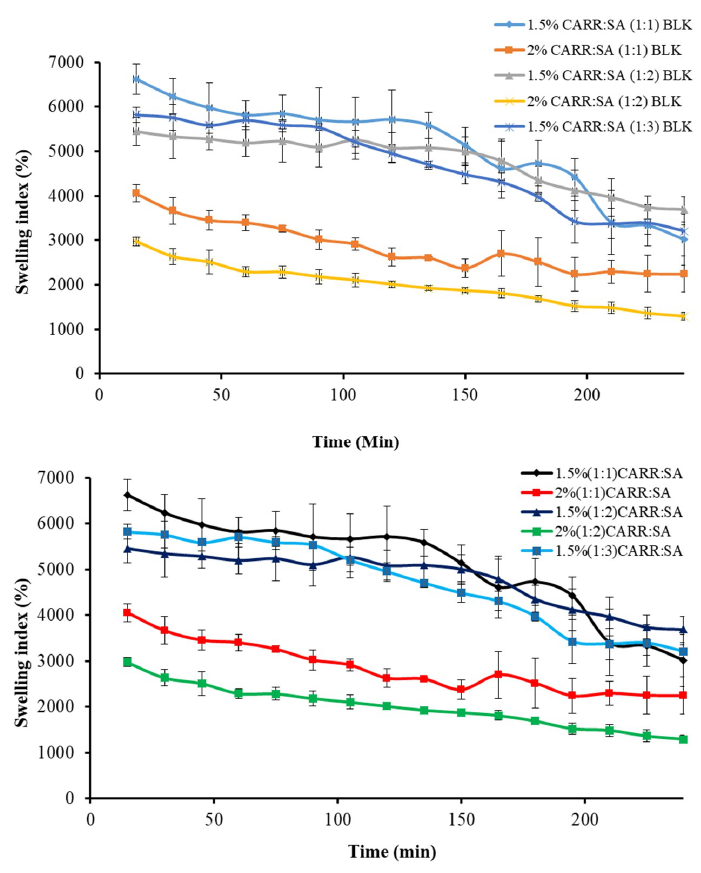
Figure 4. Swelling profiles in the presence of SWF, pH 7.5 for BLK CARR:SA (1:1 and 1:2 ratios)